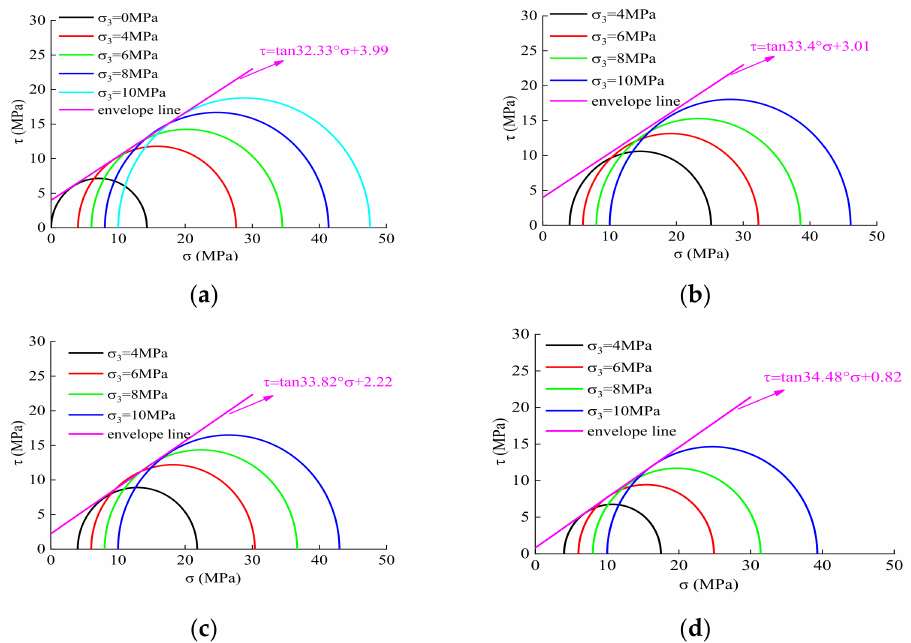
Figure 10. Mohr’s circle and envelope line under different confining pressures and seepage pres- sures: ( a ) seepage pressure is 0 MPa, ( b ) seepage pressure is 1 MPa, ( c ) seepage pressure is 2 MPa; ( d ) Seepage pressure is 3